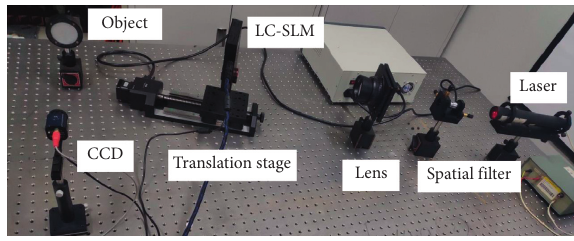
Figure 4: Experimental setup.